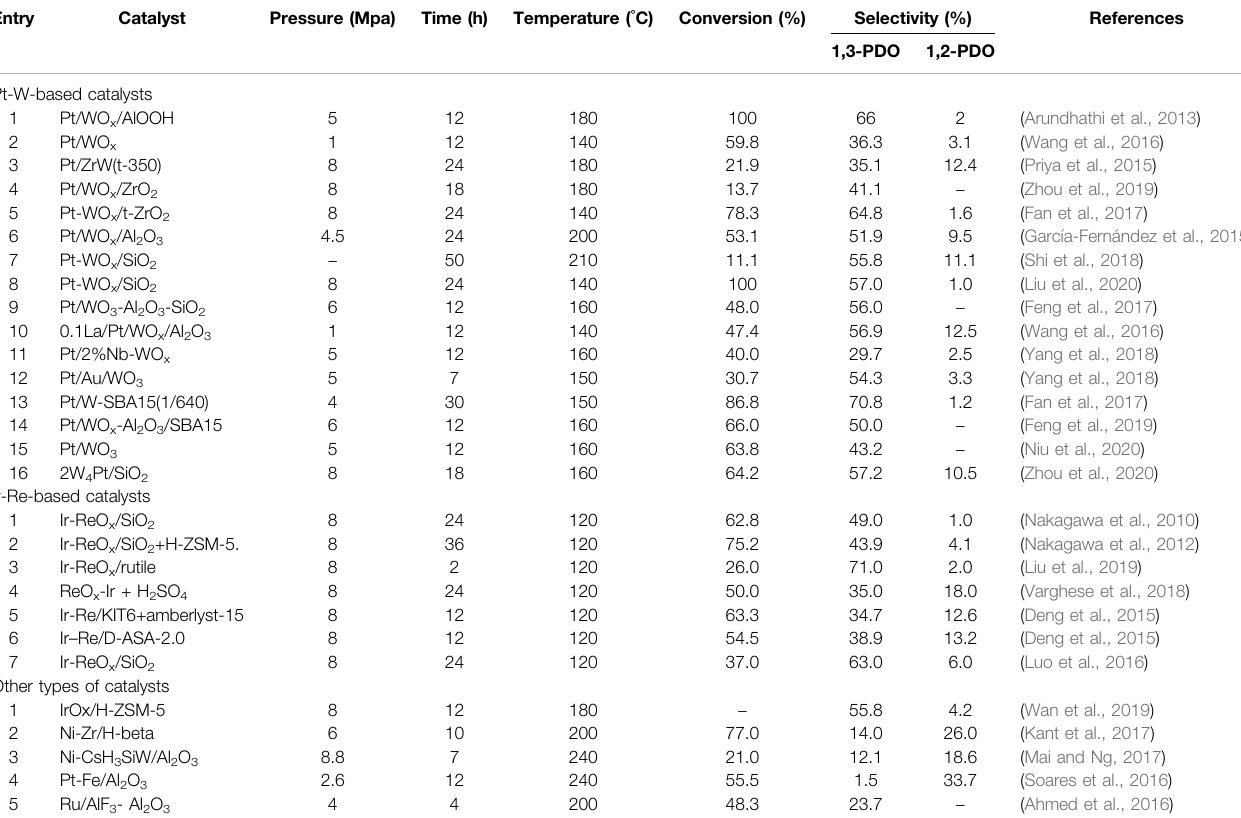
TABLE 1 | Comparison of catalytic performance in batch reactor